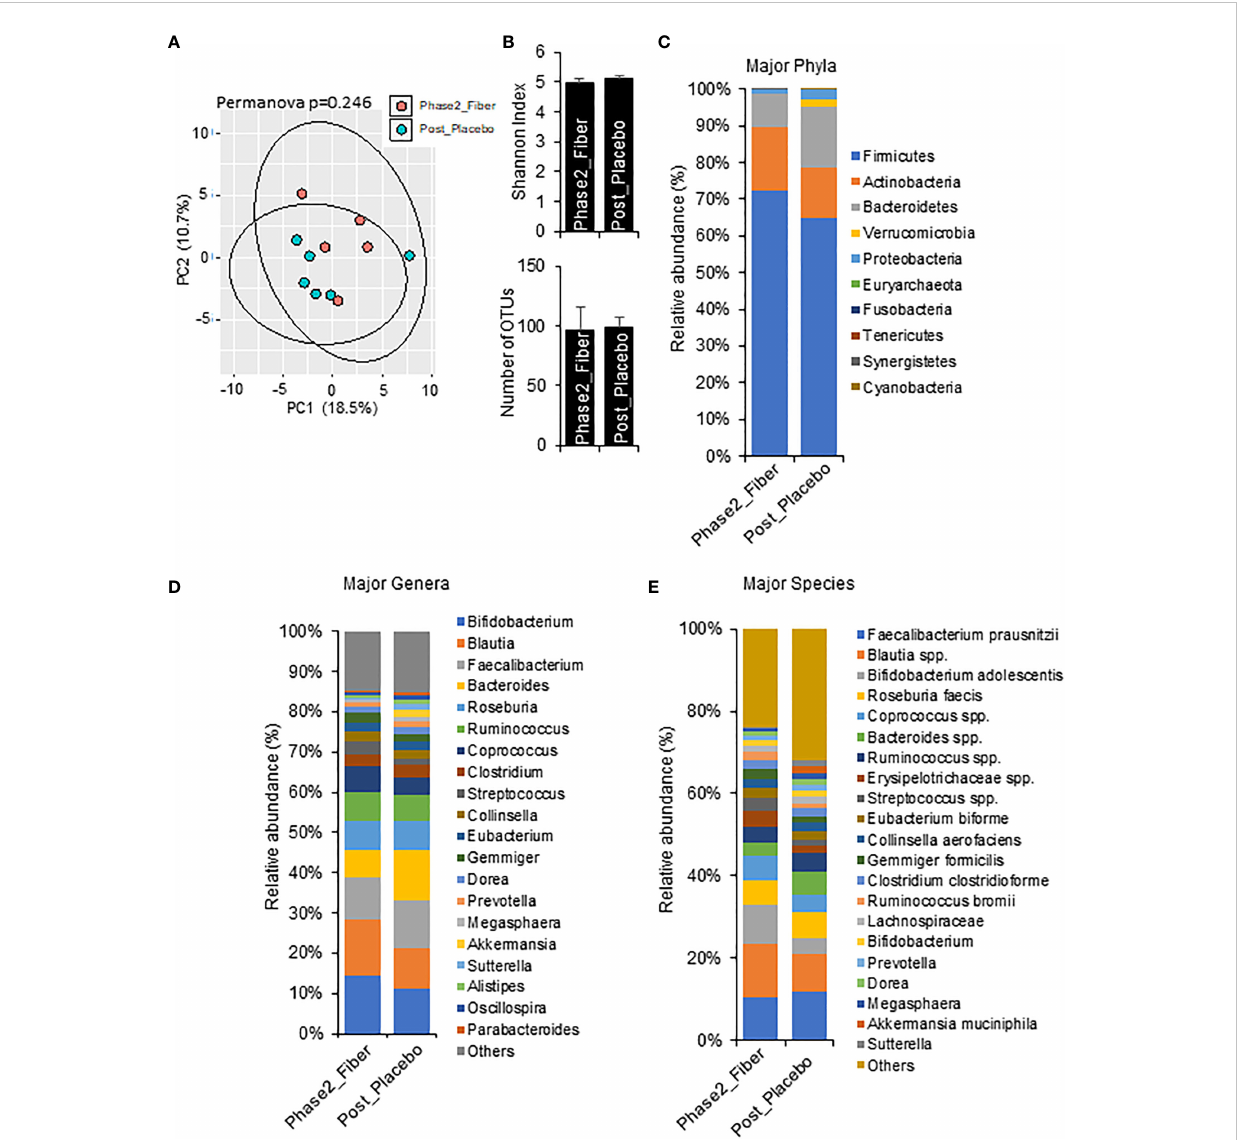
FIGURE 5 Microbiome signatures in Phase 2 prebiotic/metformin vs metformin/placebo. (A, B) Principal component analysis of beta-diversity and the alpha- diversity measure, Shannon Index and number of OTUs showed that microbiota composition was not different between Phase2_Fiber (Phase 2 prebiotic/metformin) and Post_Placebo (metformin/placebo). (C – E) The abundance of major phyla, genera, and species were similar in both groups. Data are mean and standard error of mean. Microbiome beta-diversity was assessed using the Bray-Curtis dissimilarity index and visualized with principal component analysis. The alpha-diversity indices and bacterial proportions were compared using the Kruskal-Wallis test followed by the Mann-Whitney multiple pairwise comparison